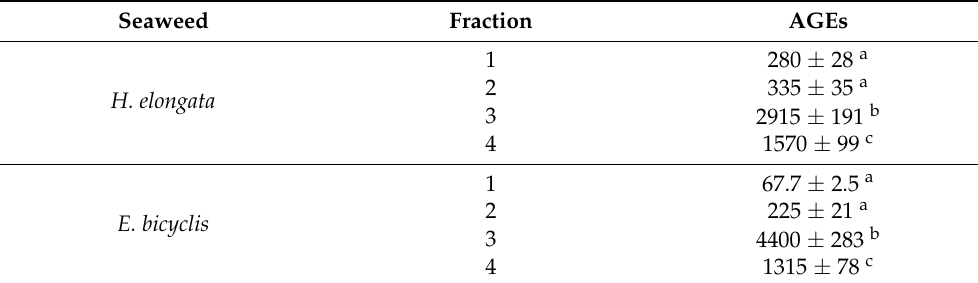
Table 2. Advanced glycation end-products (AGEs) formed during the Maillard reaction for Himan- thalia elongata (L.) S.F.Gray and Eisenia bicyclis (Kjellman) Setchell. Seaweed Fraction AGEs 1 280 ± 28 a 2 335 ± 35 H. elongata